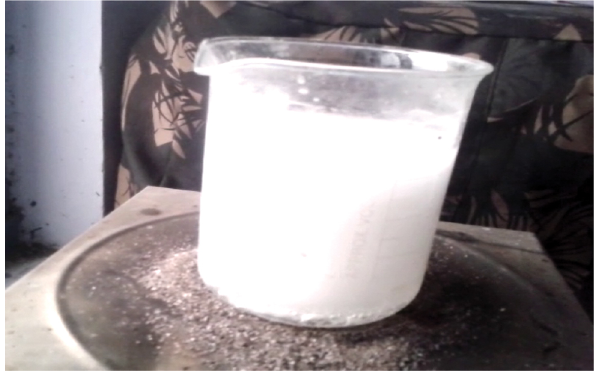
Figure 3: Starch solution at the time of stirring.